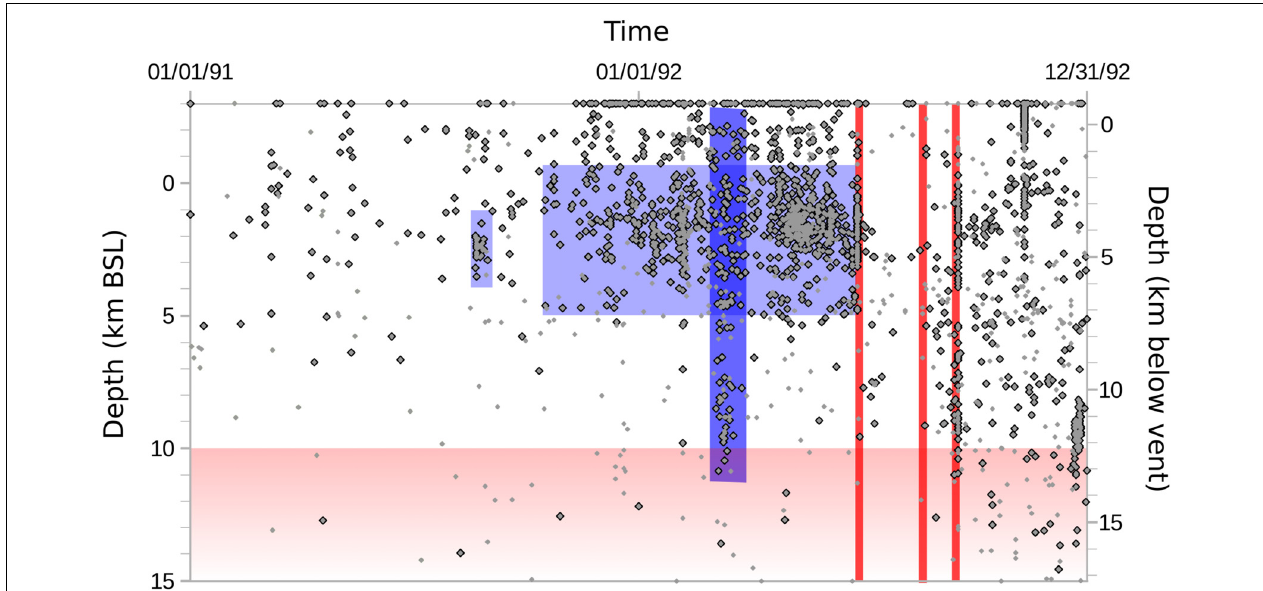
FIGURE 3 | Time-depth plot for Crater Peak, Alaska from January 1991 to December 1992. Light red – petrologically-defined magma source. Dark red – eruptions. Light blue shading shows the timing and depth of proximal precursory seismicity. The dark blue shading indicates earthquakes belonging to a distal swarm located beneath the north caldera rim, approximately 8 km NE of the vent. Gray dots show all earthquakes and black outlined dots show earthquakes with well-constrained locations. In this and the following five figures, light red grading to white indicates that the depth of the base of the mid-crustal storage region is unknown.